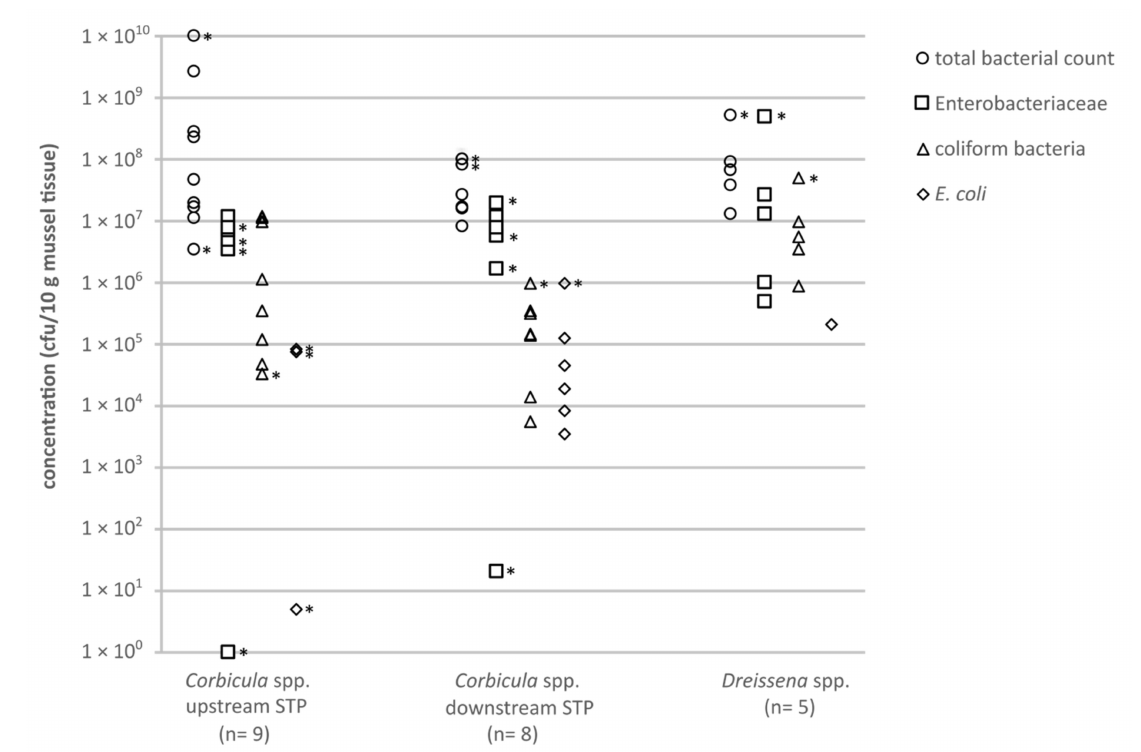
Figure 1. Concentrations (cfu/10 g mussel soft tissue) of clinically relevant bacteria from mussels, cultivated on differ- ent agars: circles = total bacteria count (TBC; Columbia blood agar); squares = Enterobacteriaceae (MacConkey agar); triangles = coliform bacteria (CC agar); diamonds = E. coli (CC agar). Asterisks mark category values of ≥ x cfu/10 g mussel tissue, the smallest possible value is